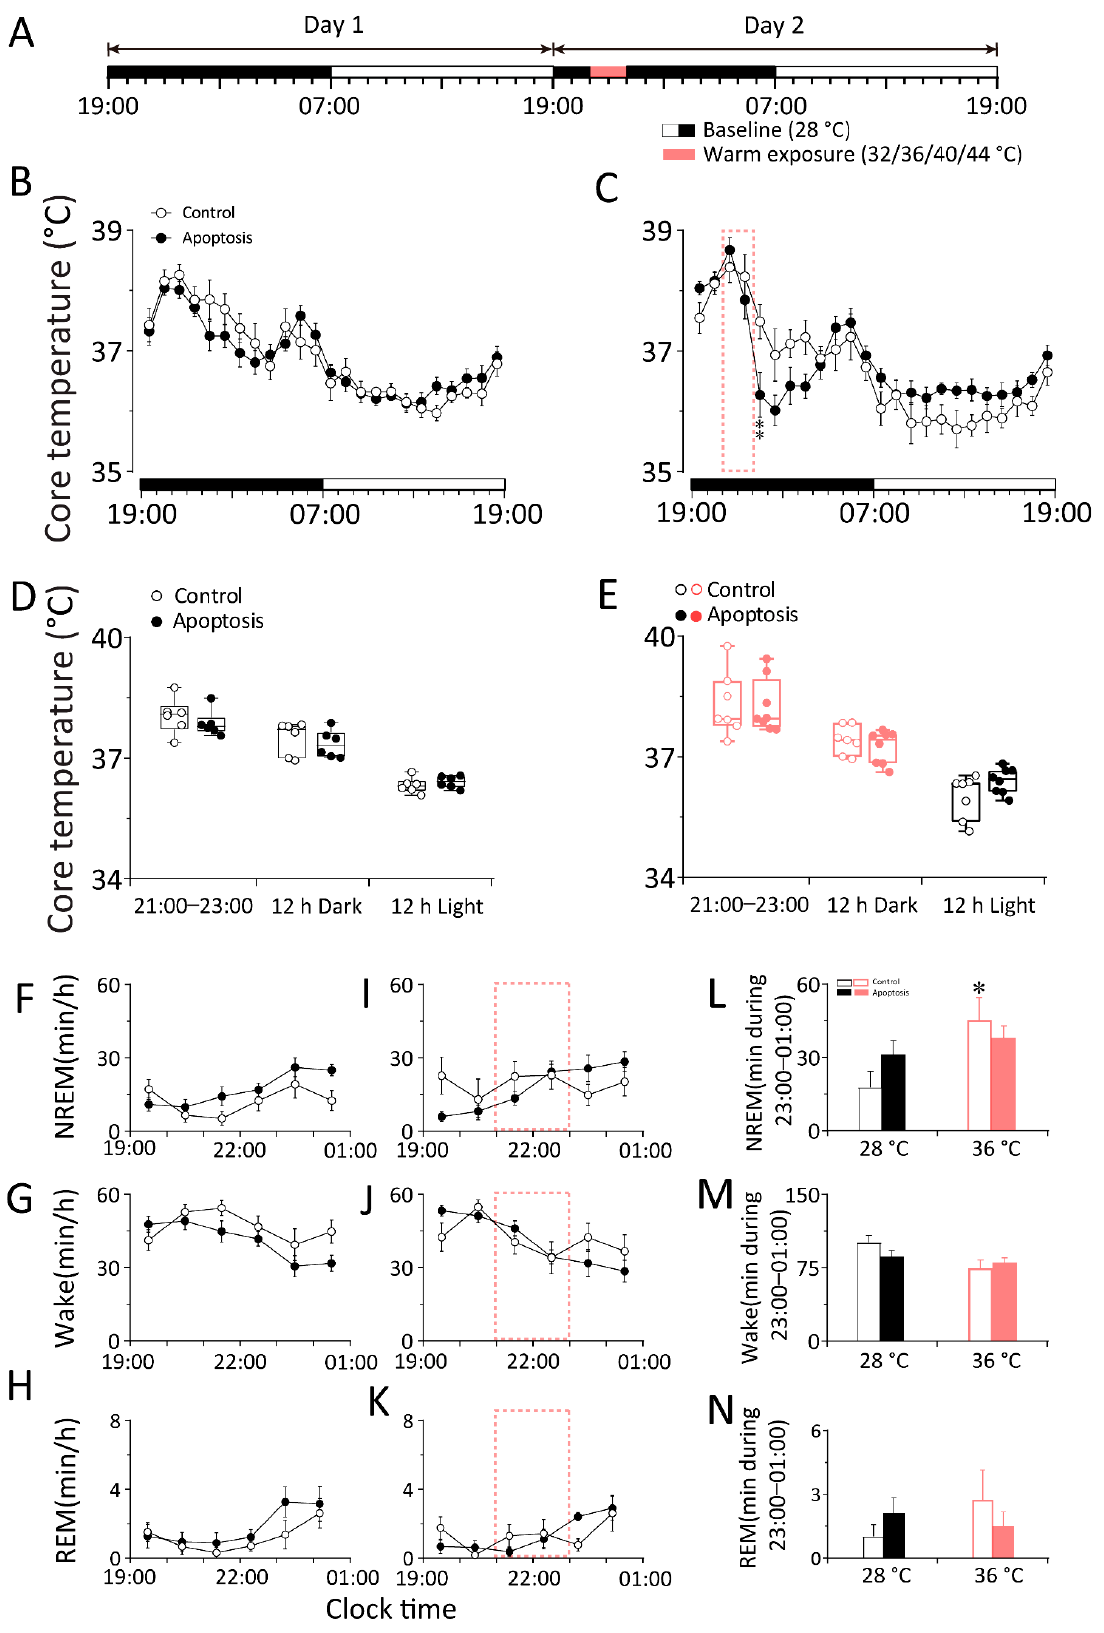
Figure 6. The apoptosis of DMH GABAergic neurons increased the core temperature fluctuation elicited by the warm exposure and alleviated the NREM sleep elicited by the warm exposure